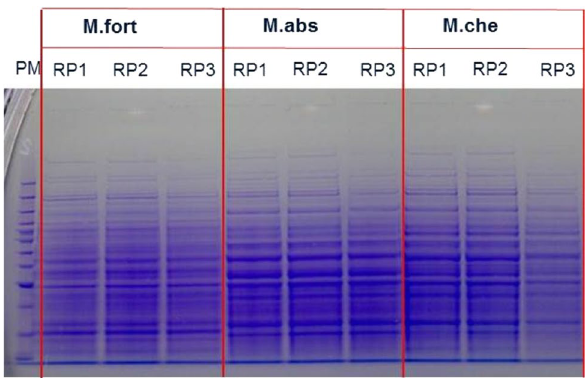
Fig. 5 Gel image of POROS RP2 SPE cleaned WCE of M. fortuitum , M. abscessus , and M. chelonae prepared using sonication lysis method with Gu-HCl as extraction solvent. 25 ug proteins were loaded on 4–12%